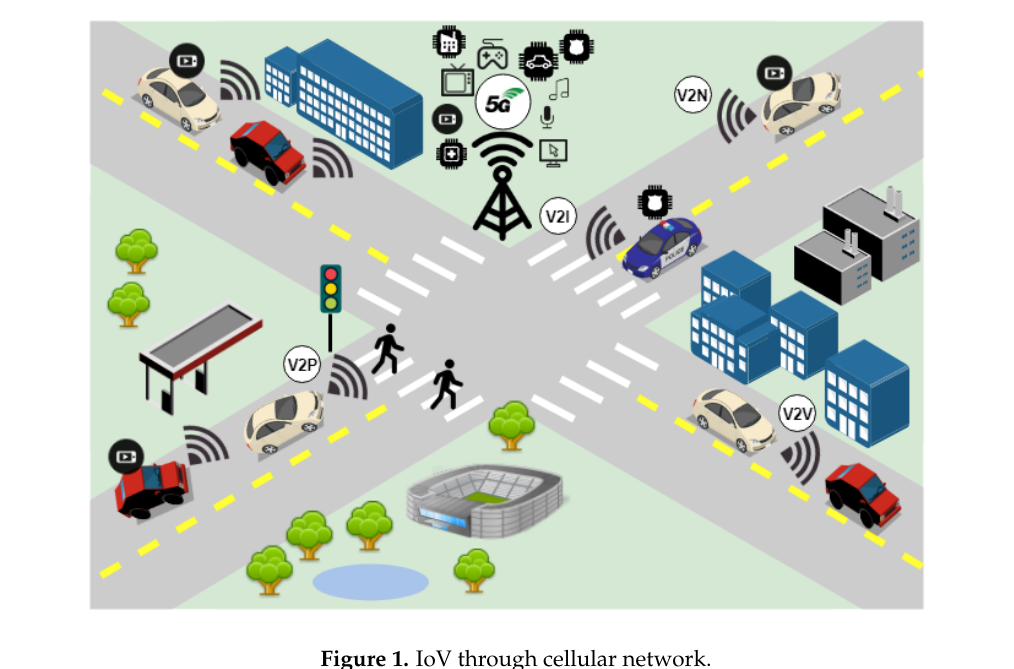
Figure 1. IoV through cellular